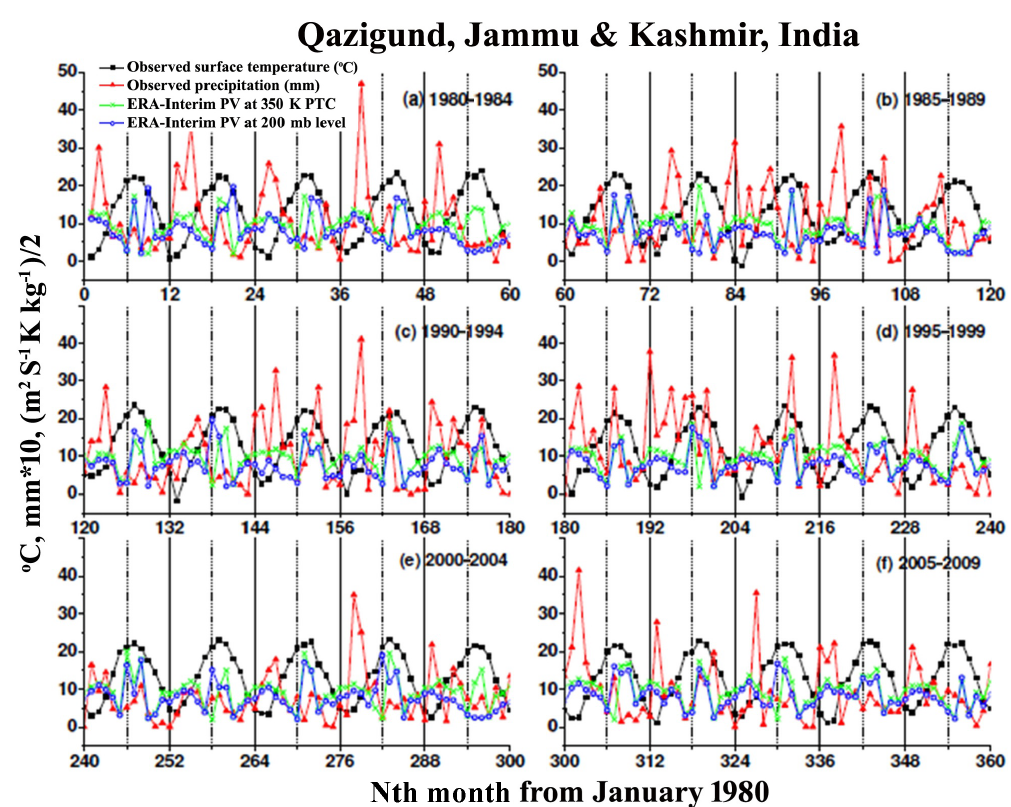
Figure 11. Same as Fig. 9 but for